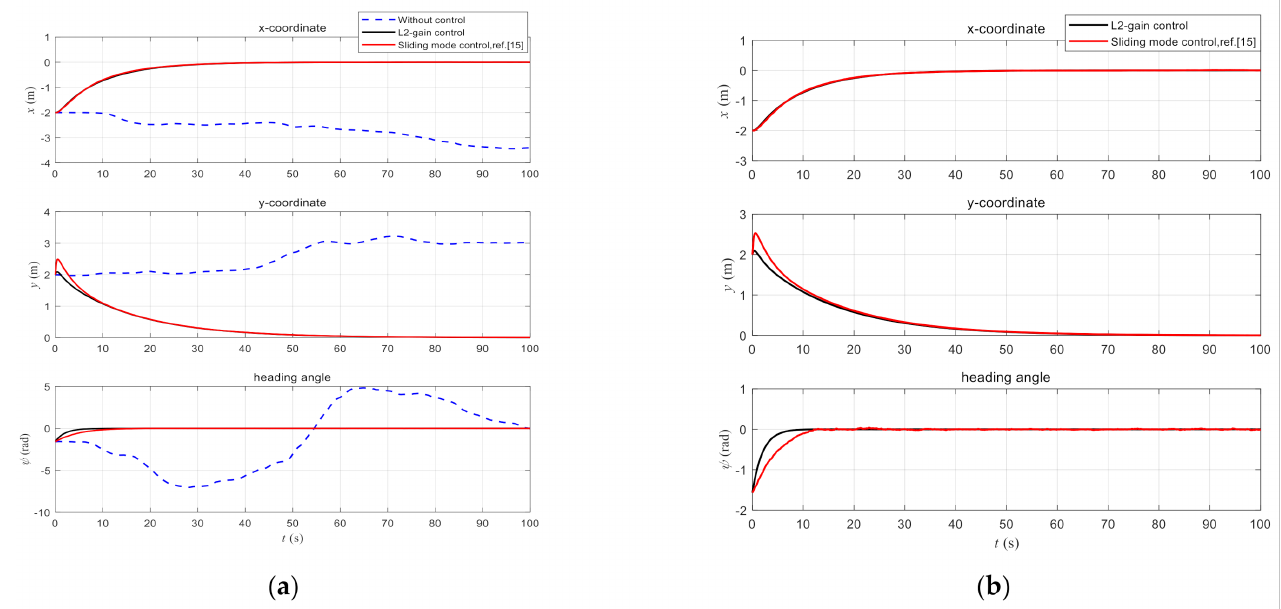
Figure 5. Position and orientation of the surface ship. ( a ) Disturbances at the level of 0.5*randn, ( b ) disturbances at the level of 0.5*randn.